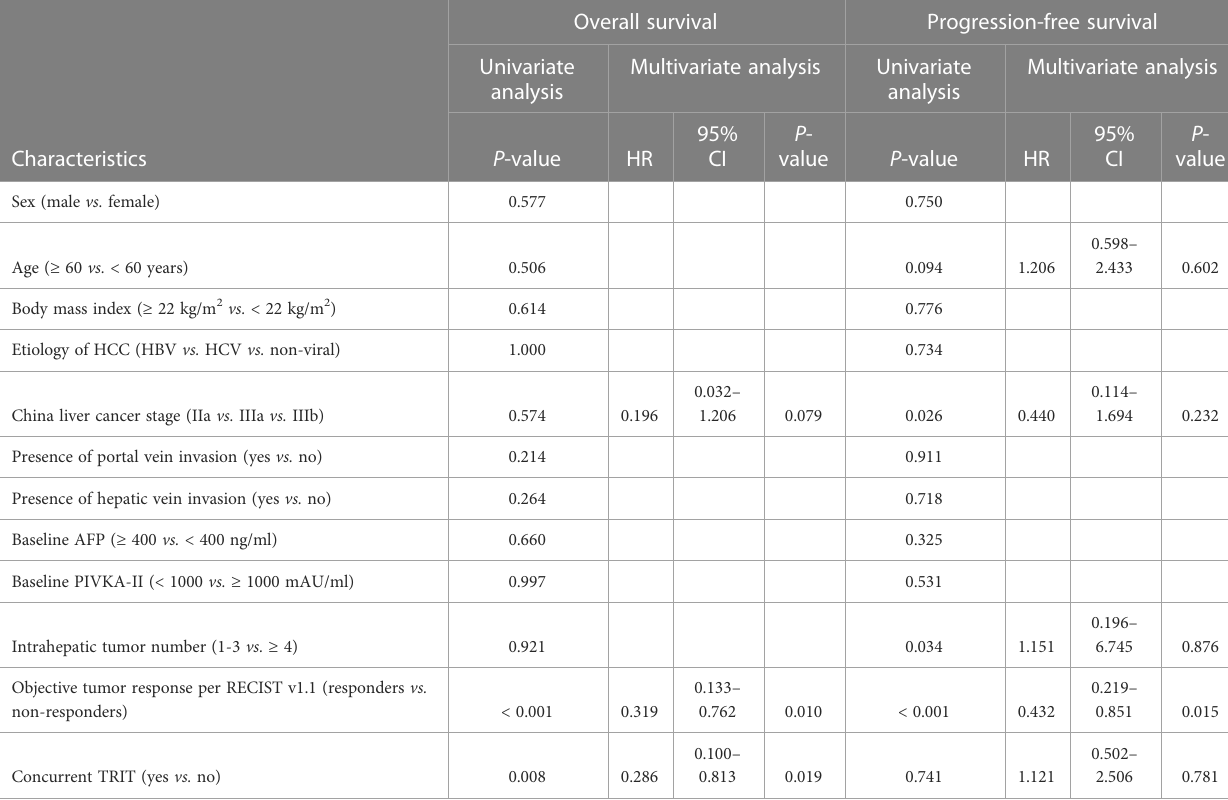
TABLE 2 The Cox regression analysis for overall survival and progression free